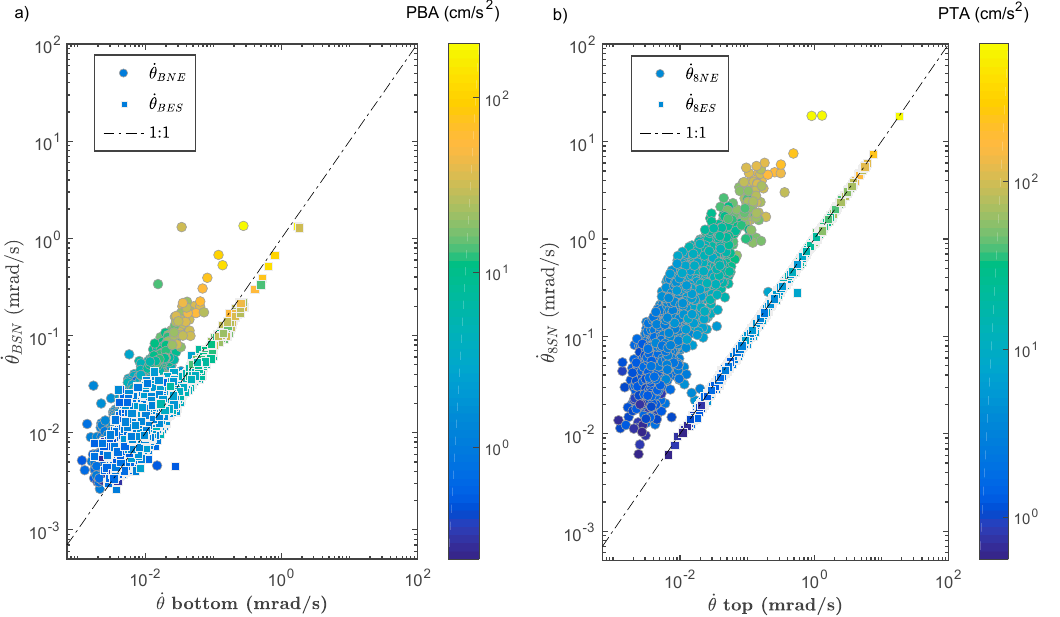
Figure 5. Comparison of the array-derived rotational rate for the ANX earthquake dataset. ( a ) at the bottom (the colour scale corresponds to the peak bottom acceleration (PBA) in cm/s 2 ). ( b ) at the top (the colour scale corresponds to the peak top acceleration (PTA) in cm/s 2 ). X-label corresponds to the bottom or top rotation rate computed with Equations (6) and (7).